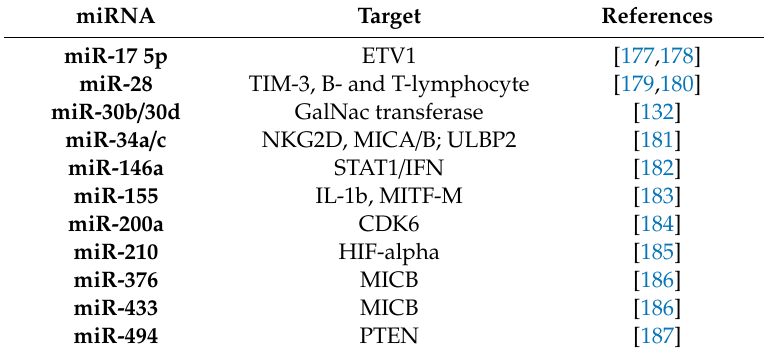
Table 3. The most representative miRNAs involved in the regulation of melanoma